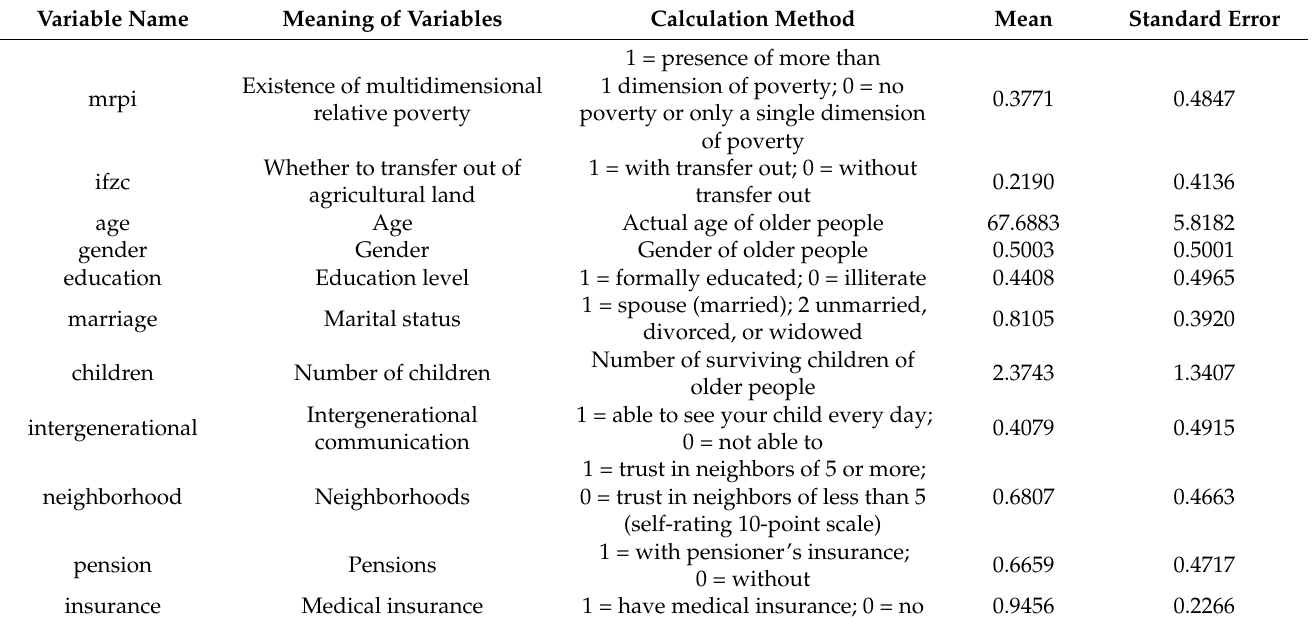
Table 3. Multidimensional relative poverty index of the rural